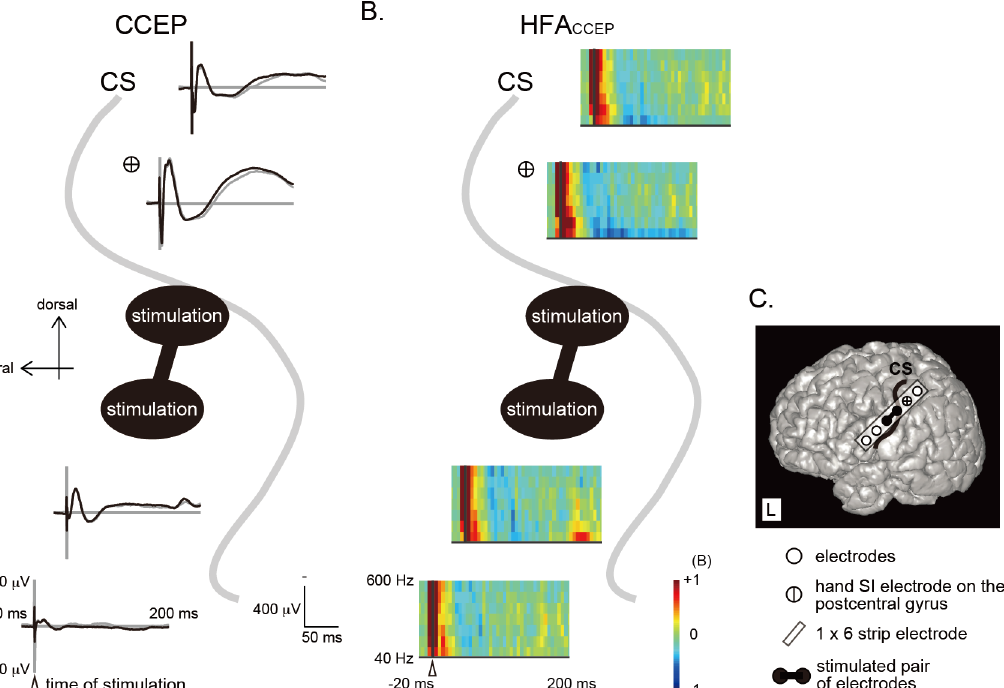
Fig 2. CCEPs and HFAs CCEP recorded from the peri-rolandic area and 3D-MRI (patient 1, left hemisphere). A: Single pulse stimulation was applied to the electrodes on the precentral gyrus and CCEPs were recorded time-locked to the stimuli (in a representative case). Two subaverages (black and grey waveforms) are shown. The vertical line corresponds to the time of single pulse stimulation (white arrowhead). B: Time-frequency representation of CCEP (HFA CCEP ) by using the short-time Fourier Transform. C: Electrodes on 3D-MRI. CCEP = cortico-cortical evoked potential. Other conventions are the same as for Fig 1.